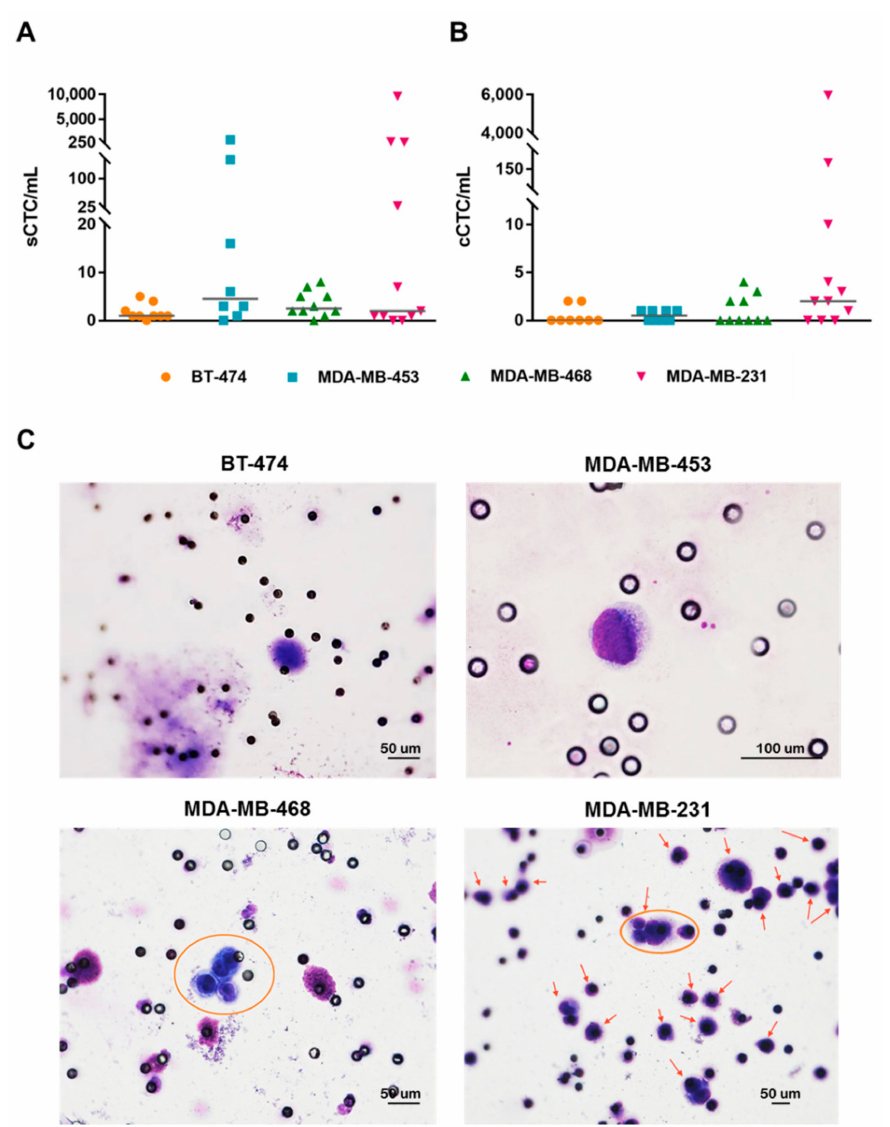
Figure 3. The single CTC (sCTC) and CTC cluster (cCTC) numbers in breast cancer xenograft models. Dot plots represent the distribution (horizontal line corresponding to the median value) of ( A ) sCTCs and ( B ) cCTCs per milliliter of blood. Images ( C ) represent May-Grünwald-Giemsa stained sCTC (40 × objective) from BT-474, sCTC (60 × oil immersion objective) from MDA-MB-453, cCTC consisting of four cells from MDA-MB-468 (circle, 40 × ), numerous sCTCs and a cCTC consisting of 4-to-5 cells (arrows, 20 × objective) from MDA-MB-231